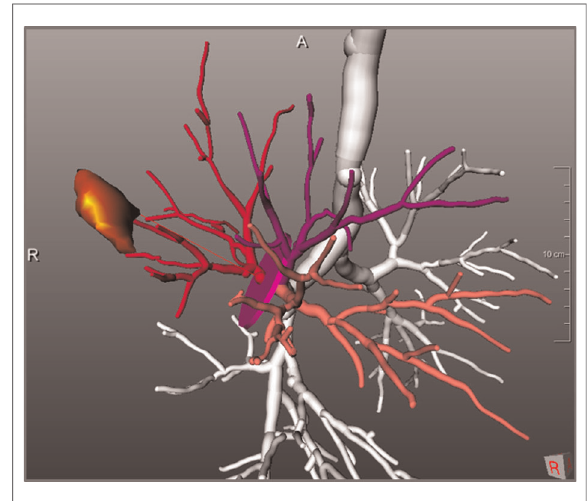
FIGURE 12 Determination of distance between tumor and resection cutting point of bronchial tree: 51